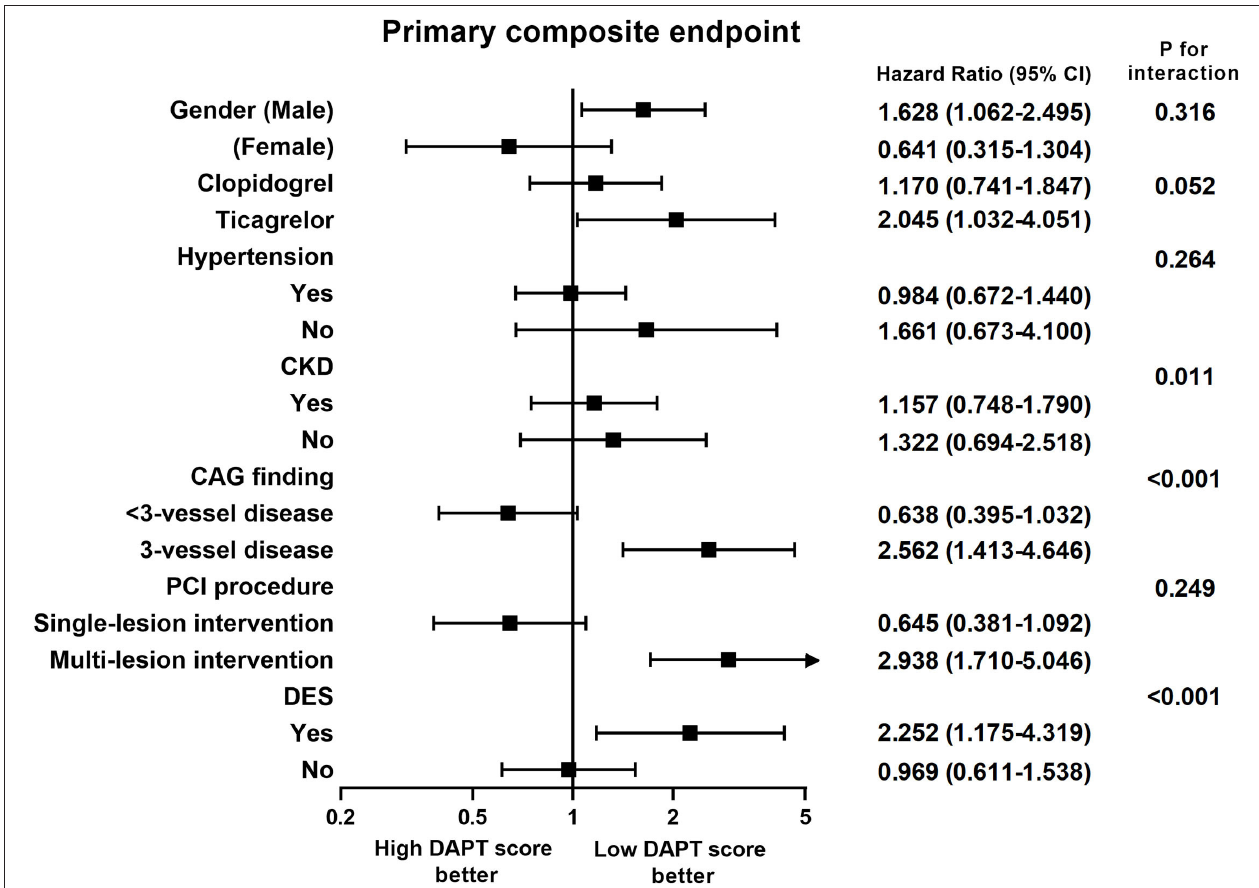
FIGURE 1 | Subgroup analysis of the effect of different dual antiplatelet therapy scores on primary composite endpoints. CAG, coronary angiography; CKD, chronic kidney disease; DES, drug-eluting stent; PCI, percutaneous coronary